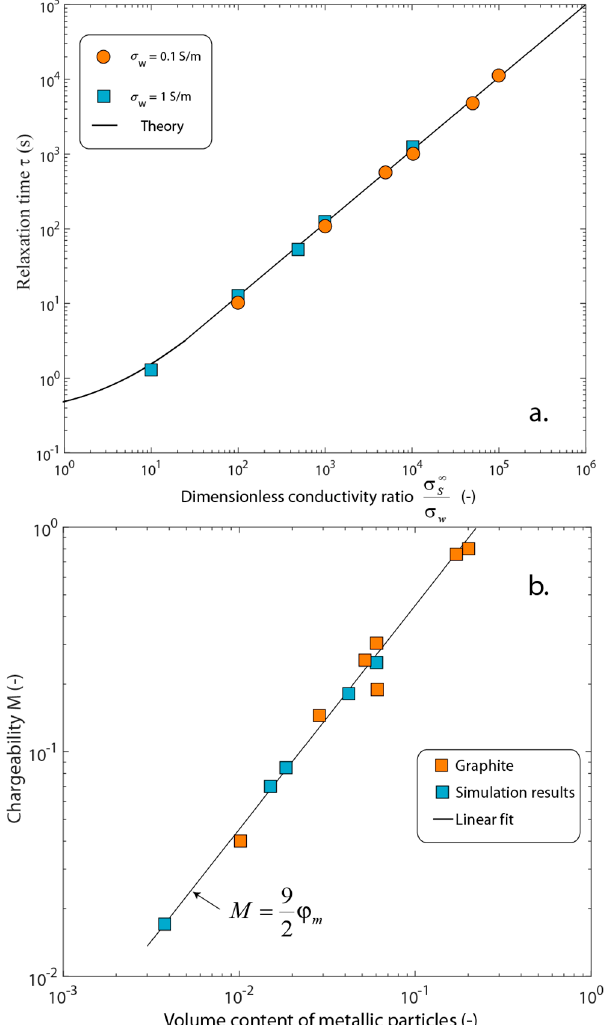
Figure 12. Finite element simulations (filled symbols) of the polarization time constant ( τ ) associated with a single metallic grain (diameter: 1 cm). The background corresponds to an electrolyte of conductivity ( σ w ). ( a ) Relaxation time. We note σ ∞ as the instantaneous conductivity of the metallic grain. We observe the relaxation time scales as (1 + σ ∞ / σ b ) (solid line) (i.e., as the ratio between the instantaneous conductivity of the metallic grain and the conductivity of the background ( σ b = σ w )). This model explains very well the observed dependence of the relaxation time on the salinity of the pore water. ( b ) Chargeability versus volume fraction of metallic particles for the 2D simulations. Modified from Abdulsamad et al. (2020) [43].